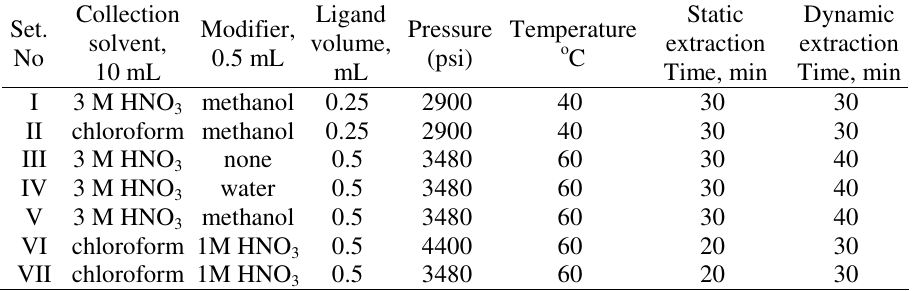
Table 1. Pressure-temperature-modifier (P-T-M) conditions applied during the SFE of CRM (NCSDC 73372) using cyanex as chelating agent